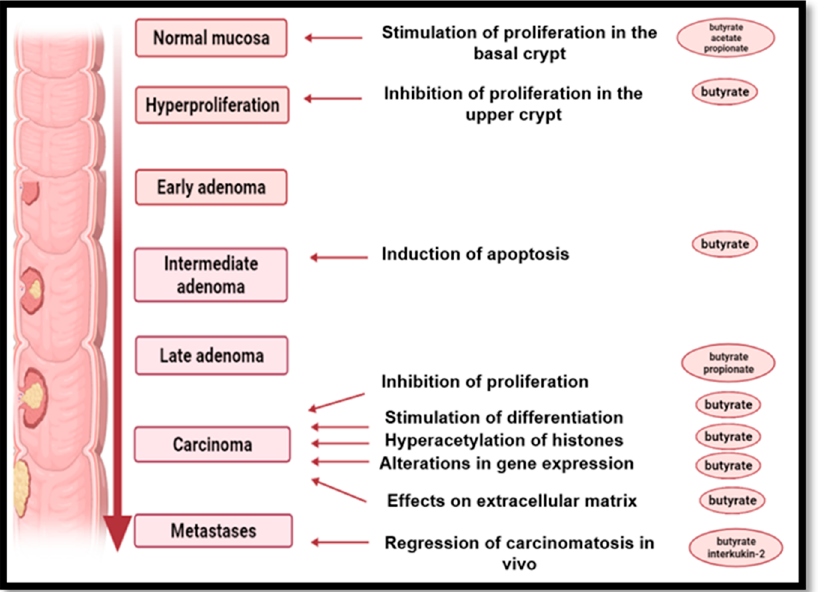
Figure 6. The impact of short-chain fatty acids on the mucosa of the colon. Created with BioRen- der.com.